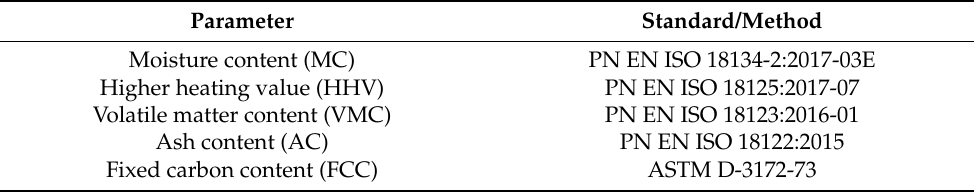
Table 1. Standards and methods used during the proximate